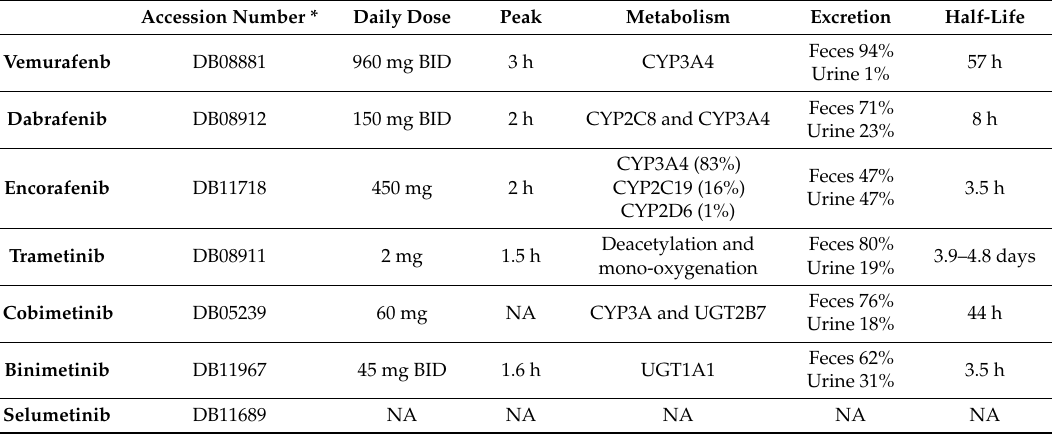
Table 3. Pharmacological characteristics of BRAF/MEK